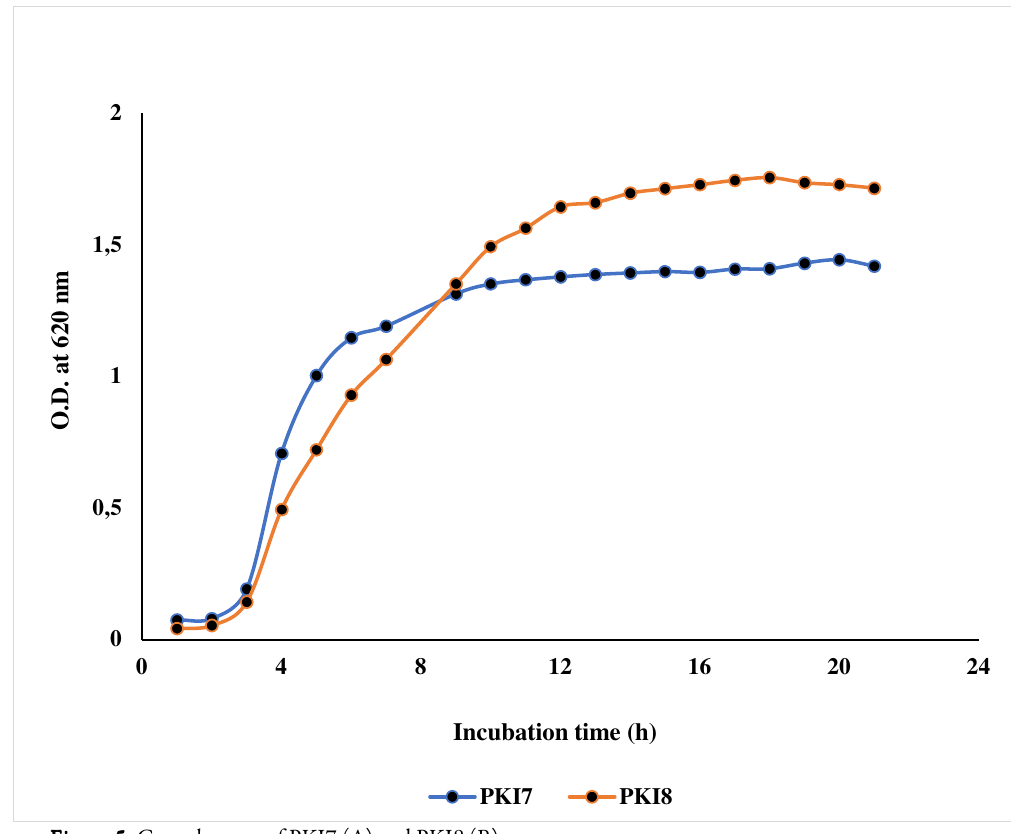
Figure 5. Growth curve of PKI7 (A) and PKI8